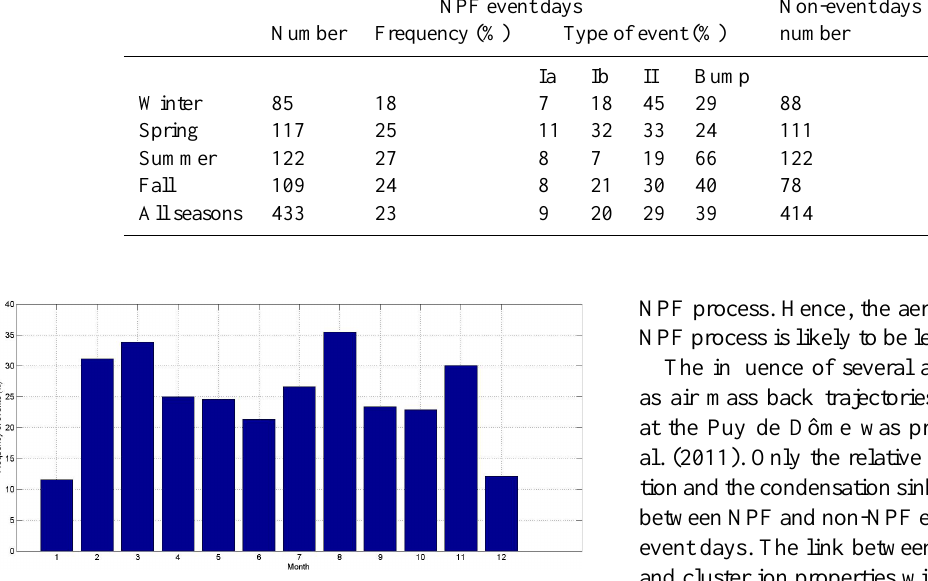
Fig. 1. Monthly mean nucleation frequencies at the Puy de